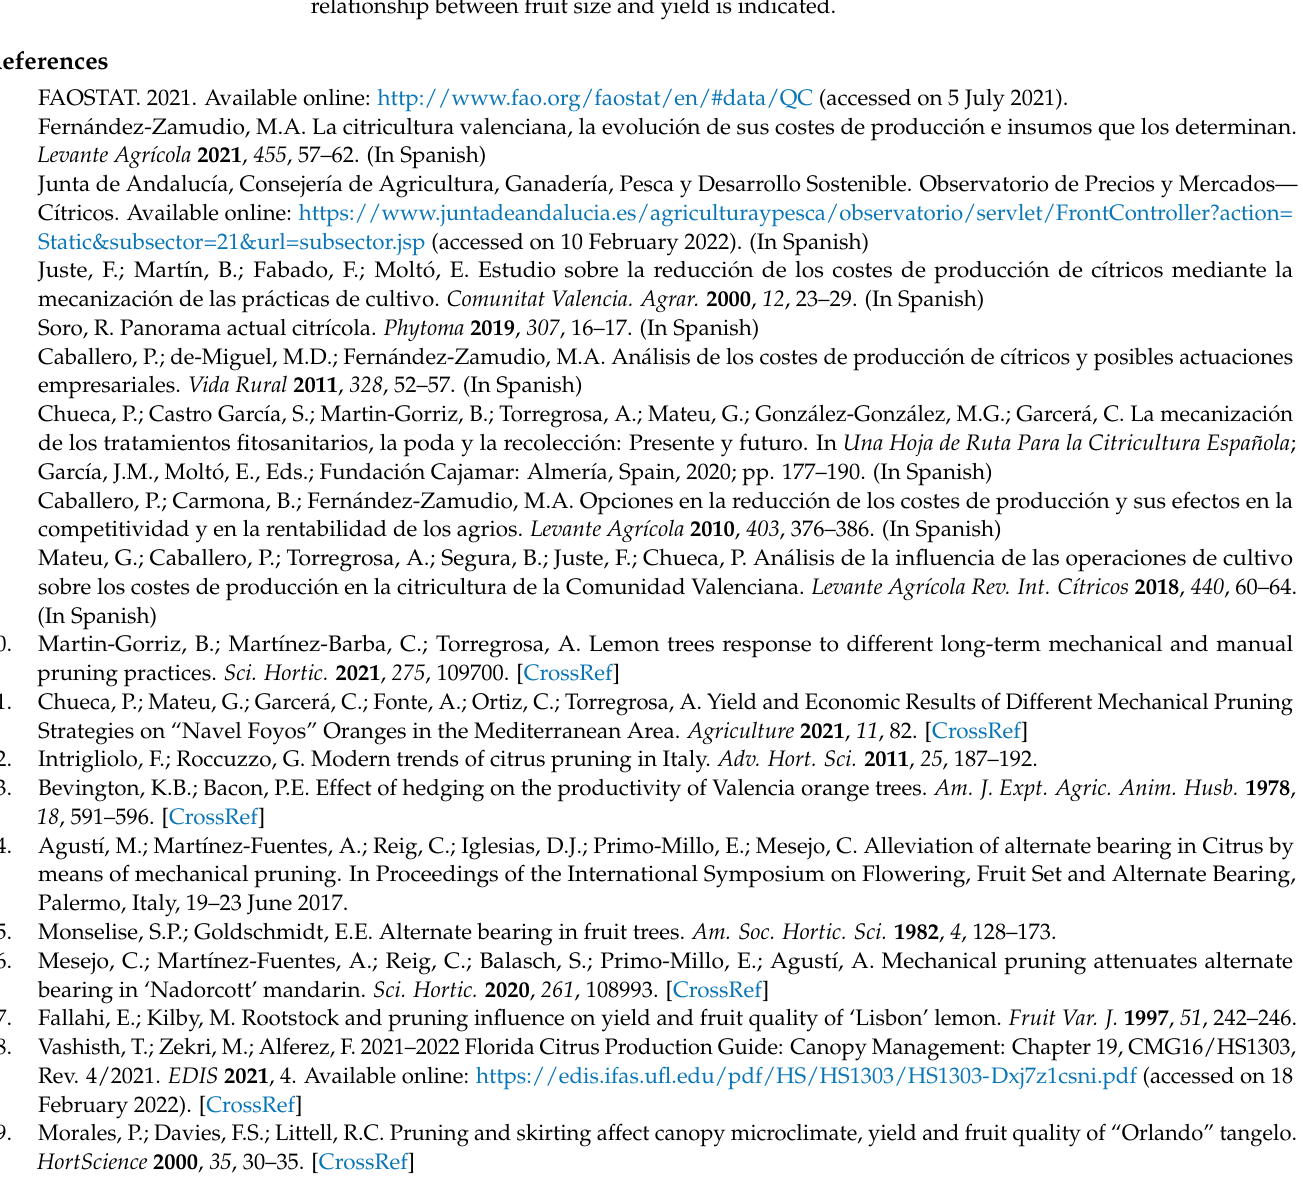
Figure A2. Average fruit size (equatorial diameter, mm) versus total yield (kg ∙ tree − 1 ) for each tree under study during the four years of trials (N = 219). The model equation that describes the relationship between fruit size and yield is indicated.